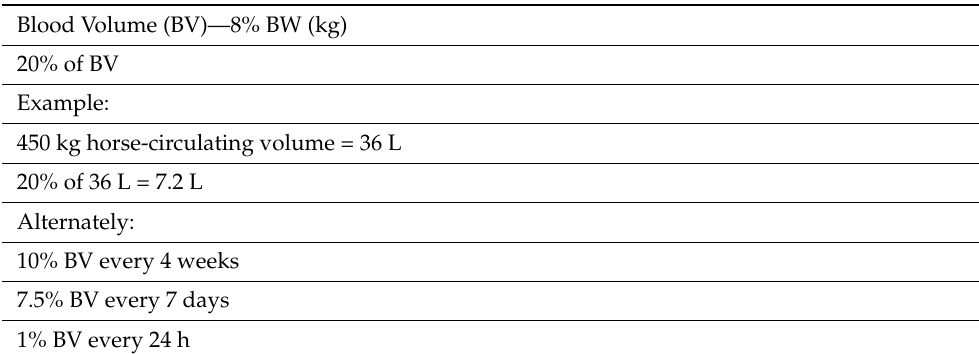
Table 3. Volumes and frequencies of blood that can be safely harvested from donor horses without detriment to